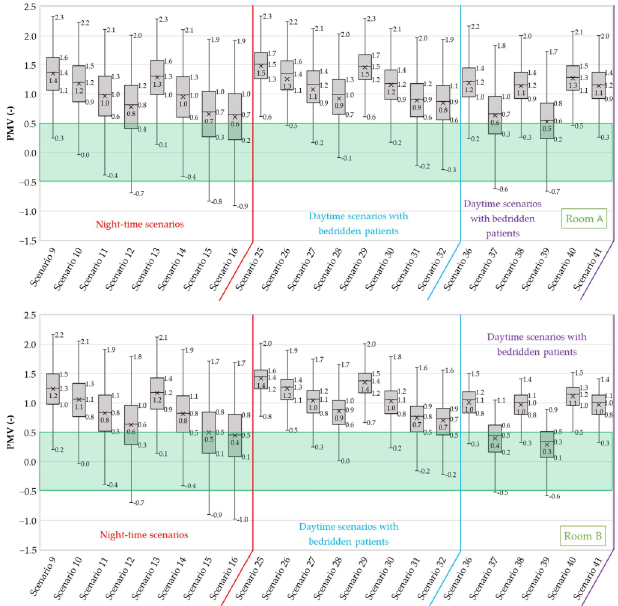
Figure 23. PMV distributions of the different scenarios in summer